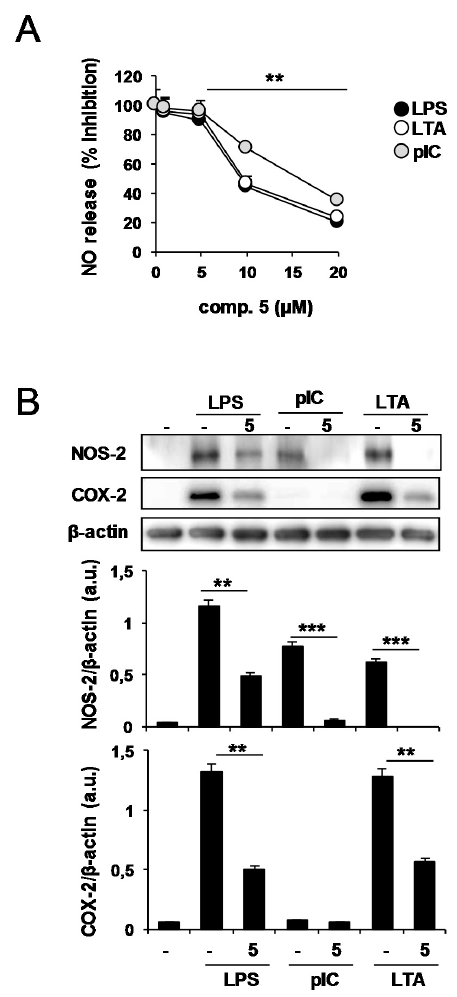
Figure 8. Compound 5 inhibits NO release and gene expression mediated by different Toll-like receptors (TLRs). ( A ) Peritoneal macrophages were incubated with diterpene 5 (5–20 µ M) or vehicle for 30 min, followed by stimulation with (TLR ligands): LPS 200 ng/mL (TLR4 ligand), polyriboinosinic–polyribocytidylic acid (poly I:C) 20 µg/mL (TLR3 ligand), or lipoteichoic acid (LTA) 10 µg/mL (TLR2 ligand) for 24 h. The accumulation of nitrite in the culture medium was measured with the Griess reagent. Experiments were carried out in triplicate and results show the mean ± SD of three independent experiments. ( B ) Peritoneal macrophages were incubated with diterpene 5 (20 µ M) or vehicle for 30 min, followed by stimulation with TLR ligands for 20 h. NOS-2 and COX-2 proteins were detected by Western blot and β -actin was used as a loading control. A representative experiment of three is shown. Densitometry analysis shows the mean ± SD of three independent Western blot experiments. ** p < 0.01, *** p <